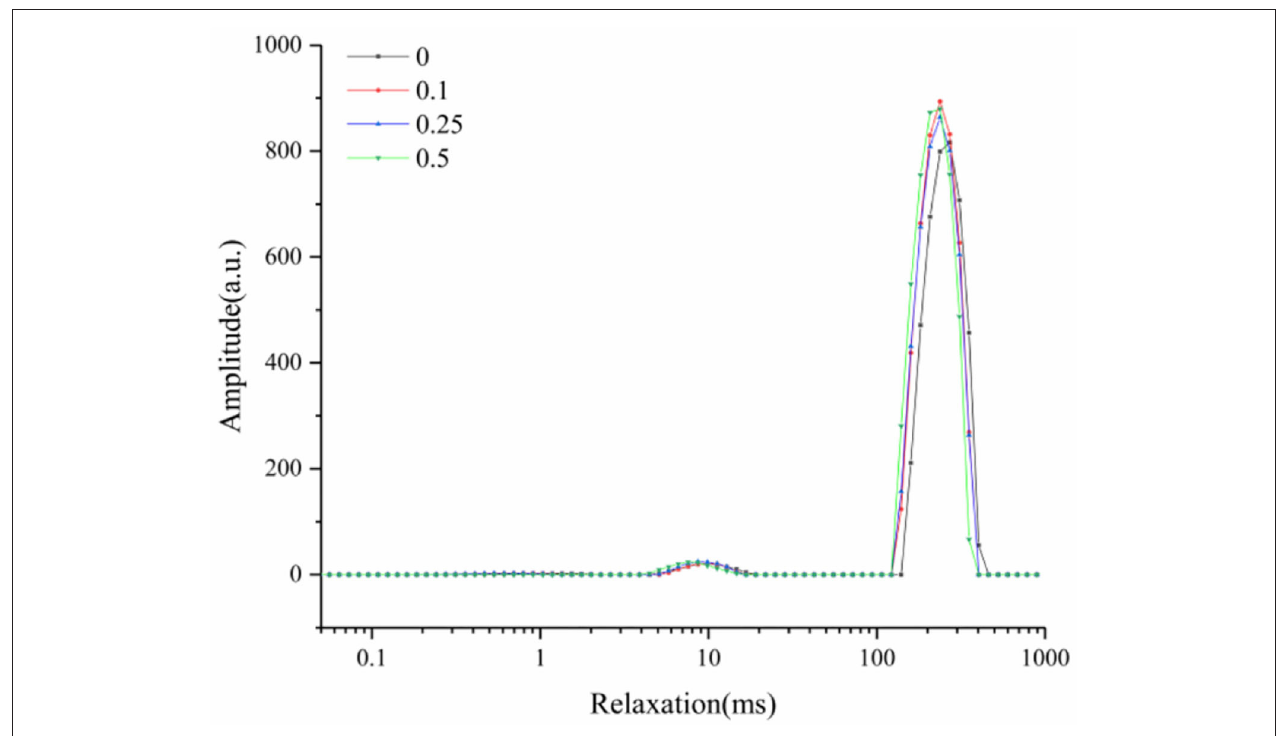
FIGURE 7 | Low-field NMR spectra of